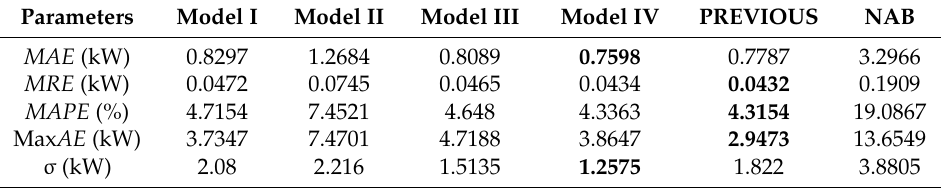
Table 21. Results obtained by neural network and NAB models over Test G, for a PH of 1 h. Parameters Model I Model II Model III Model